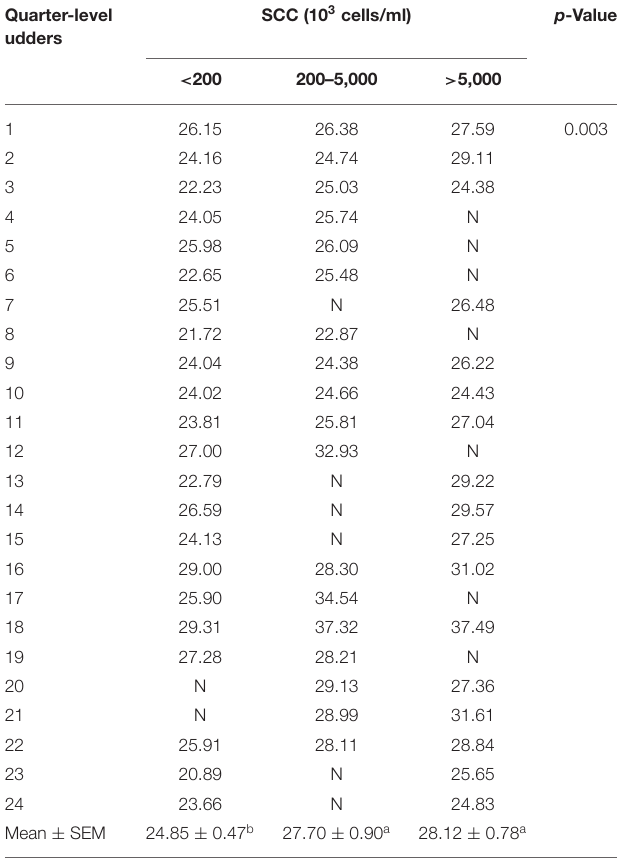
TABLE 3 | Pearson correlations coefficients between echotextural characteristics of mammary gland parenchyma and SCS ( n = 94 test-day records). Variable